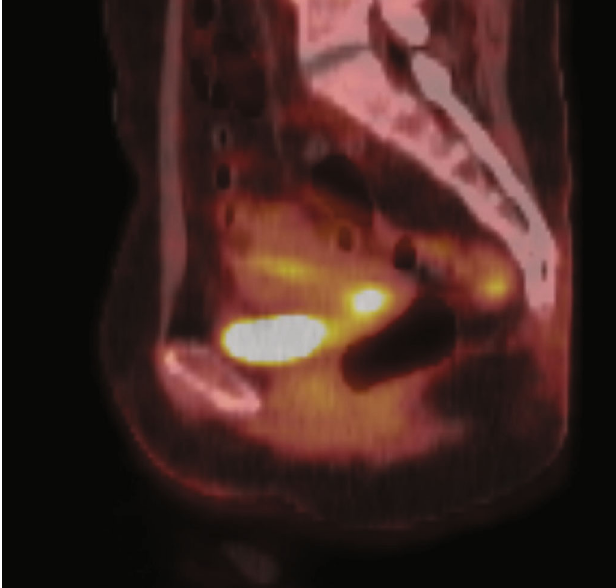
Figure 3: PET CT sagittal scan postradiation and presurgery with demonstration of a metabolically active mass within the cervix, consistent with the patient ’ s known